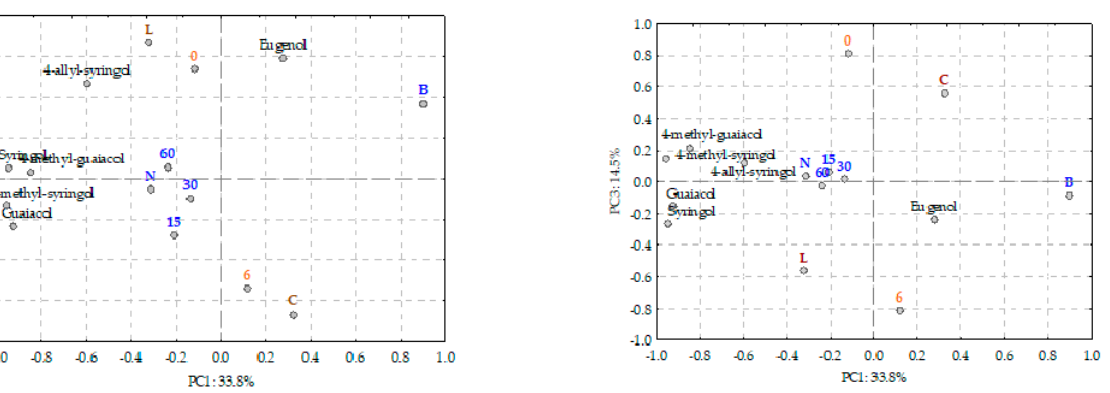
Figure 2. PCA representation of loadings and scores of all AWS samples and all volatile phenols analysed. Legend: C and L stand for the wood used in the ageing process, Chestnut and Limousin respectively; O15, 30 and 60 are the different micro-oxygenation modalities used in the alternative system; N—without micro-oxygenation; B—Barrel; 0—0 months in bottle; 6—6 months in bottle.